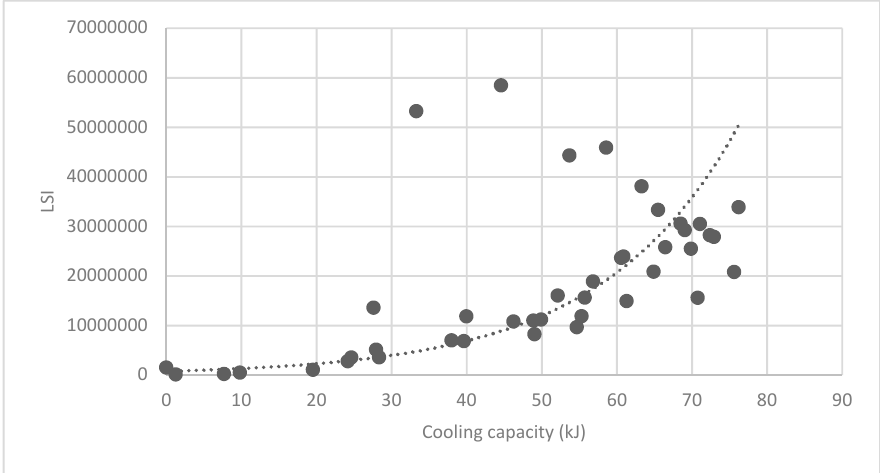
Figure 27. Association between brush LSI and cooling capacity.